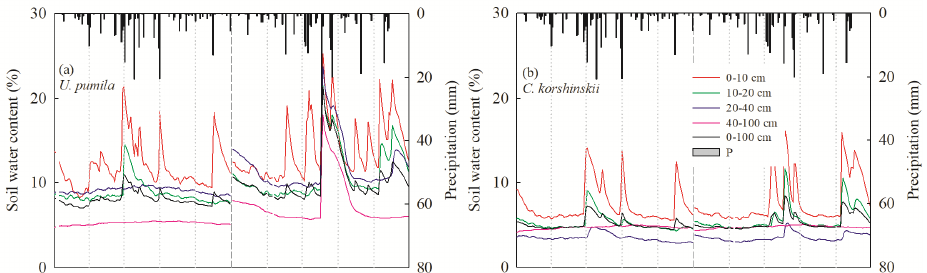
Figure 3. Daily precipitation and volumetric soil water content (0–100 cm) from May 1 to Septem- ber 30 in ( a ) U. pumila and ( b ) C. korshinskii.